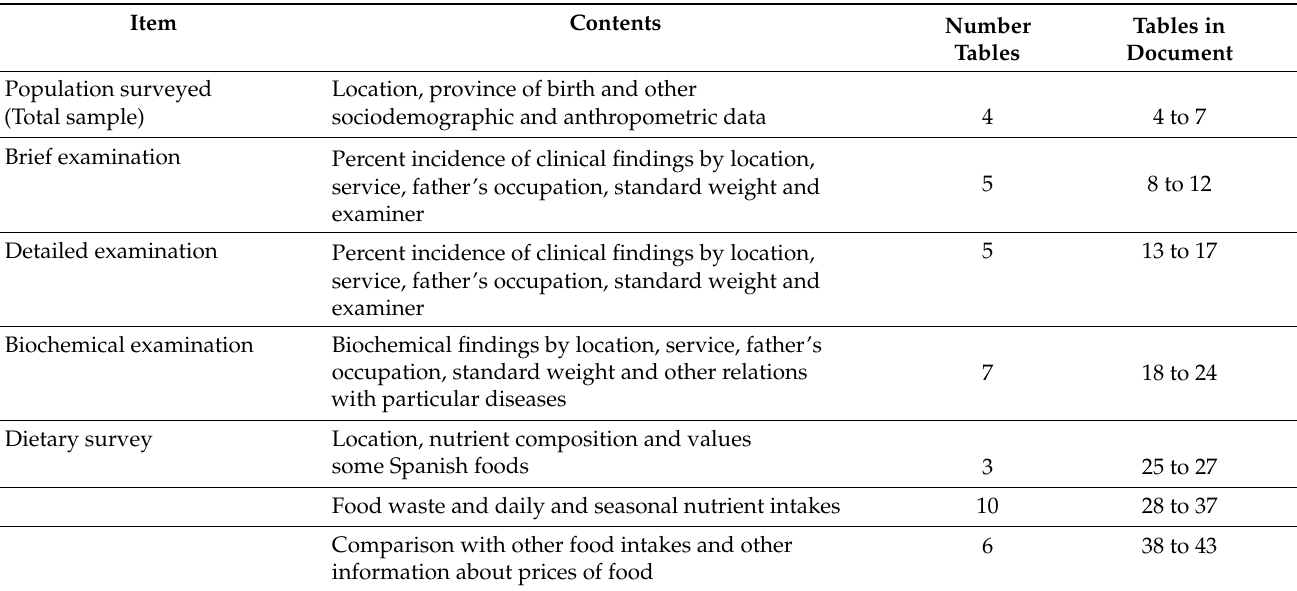
Table 1. Spain: Nutrition Survey of the Armed Forces. Table of